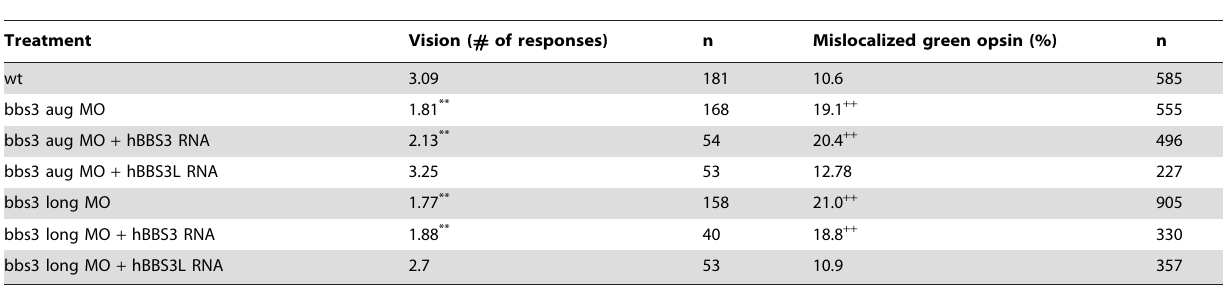
Table 1. Vision startle assay and percentage of green opsin mislocalization.